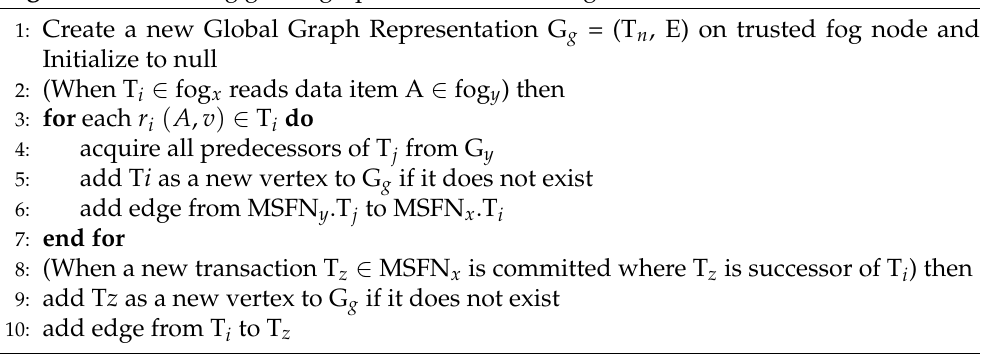
Algorithm 2 Building global graphs on the trusted fog